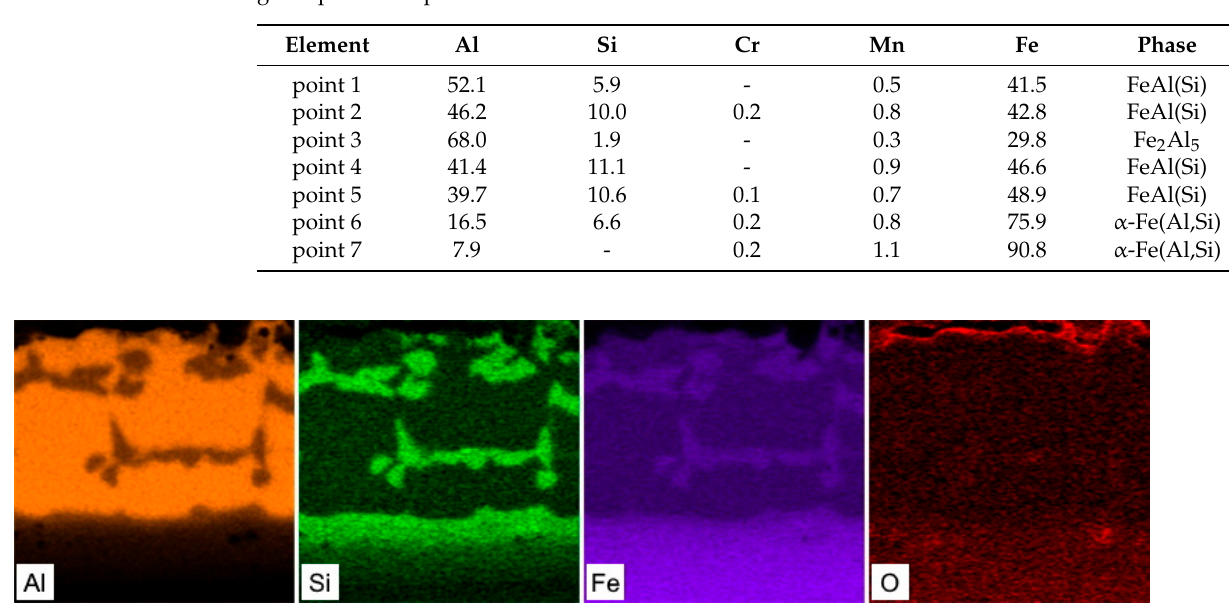
Figure 5. SEM-EDS elemental distribution maps of the Al-Si coating on the die-quenched 22MnB5 boron steel. The island-like phase (labeled with points 1, 2, and 4 in Figure 4a) contained from